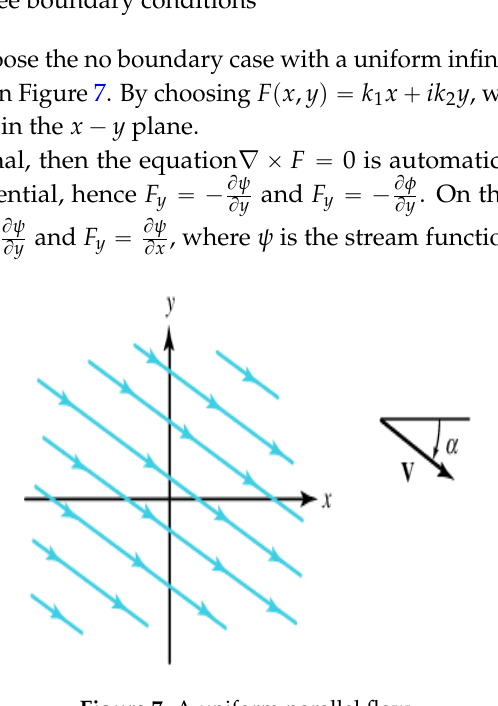
Figure 7. A uniform parallel flow.